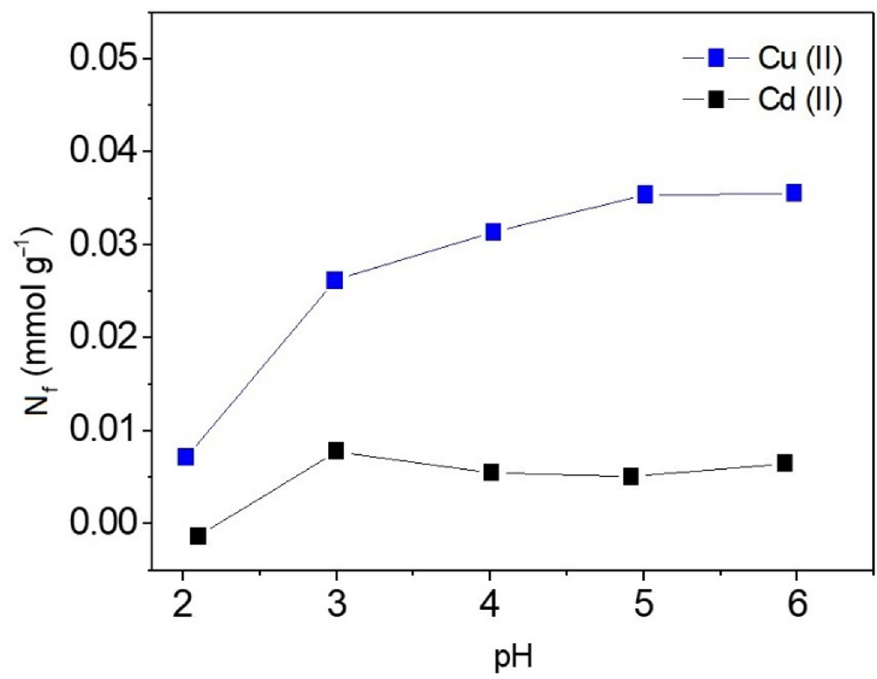
Figure 7. Effect of pH on the adsorption of Cu(II) and Cd(II). Mass of adsorbent = 20.0 mg; solution volume = 1.80 mL.